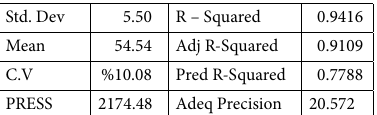
Table 2. Other statistical parameters of this model.